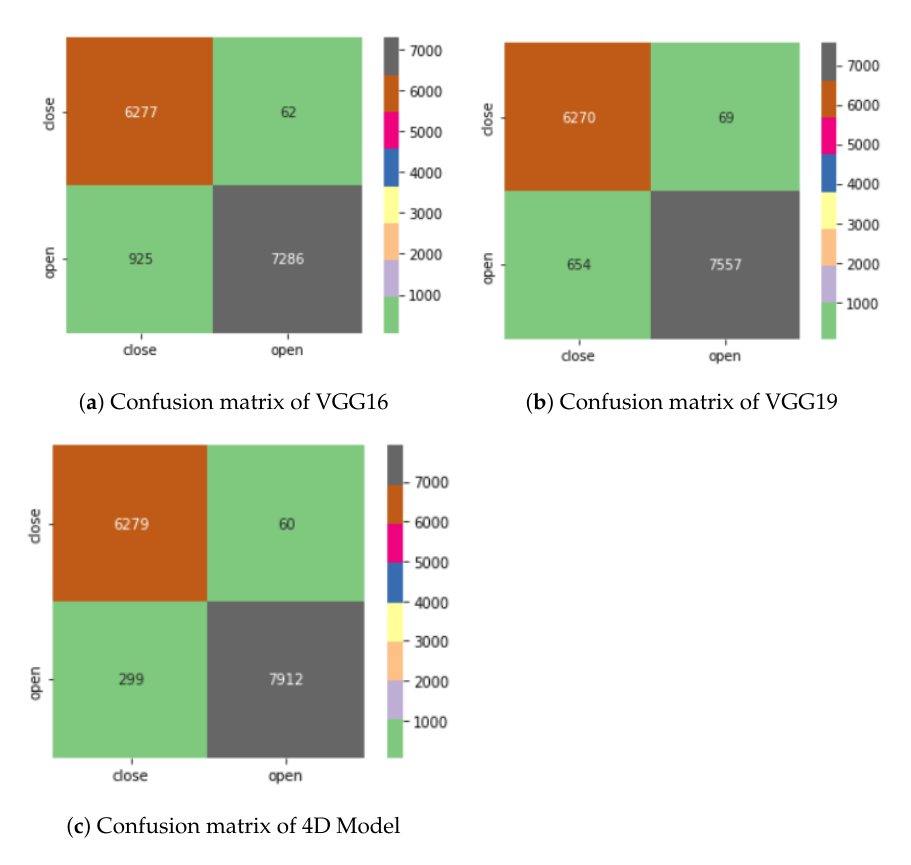
Figure 12. Confusion matrices of different